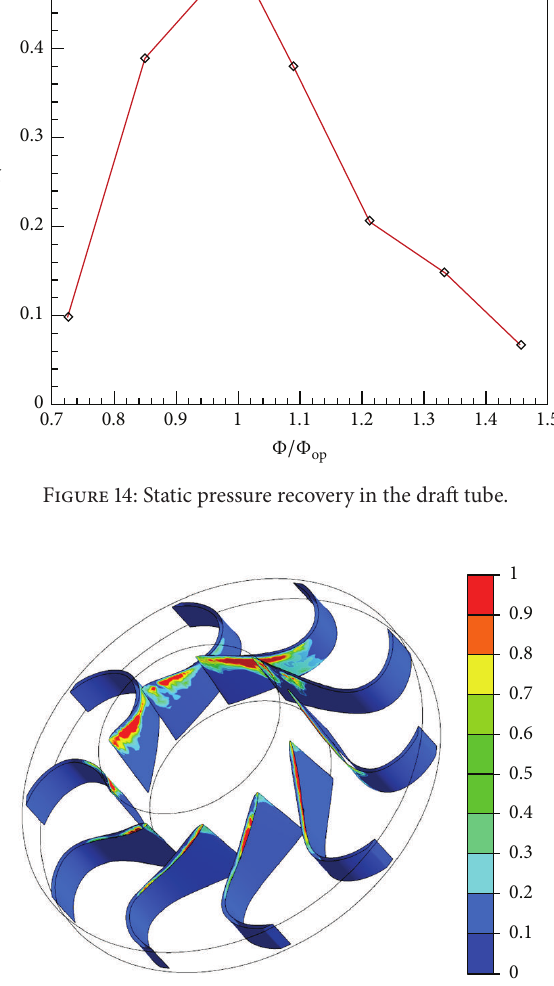
Figure 15: Water vapor volume fraction at the small flow